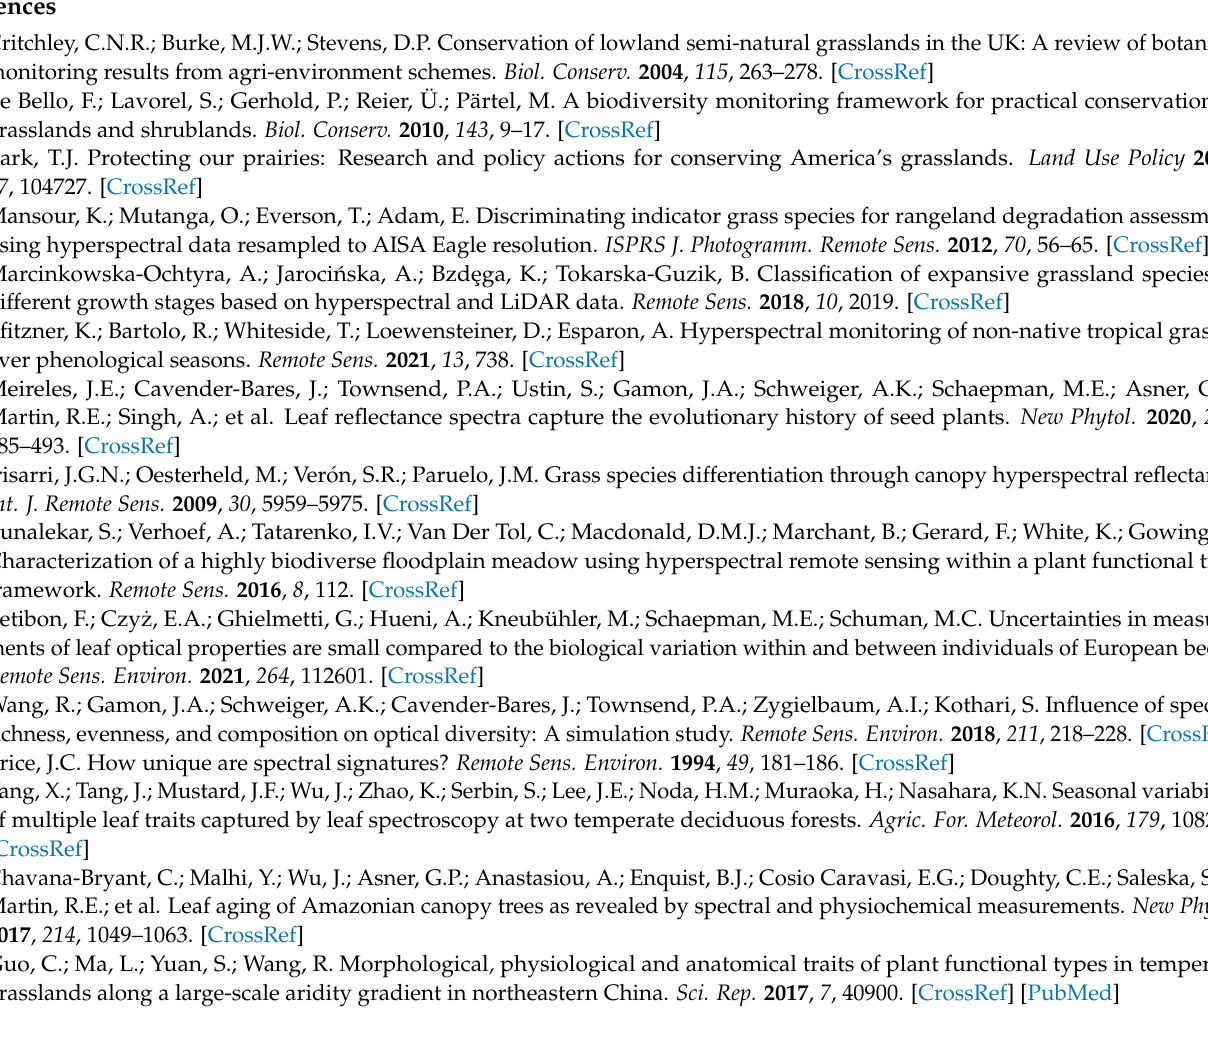
DA models, Figure S2: Differences in distributions using Euclidean Distance, Figure S3: Differences in distributions using SAM, Figure S4: Ease of classification based on the number of